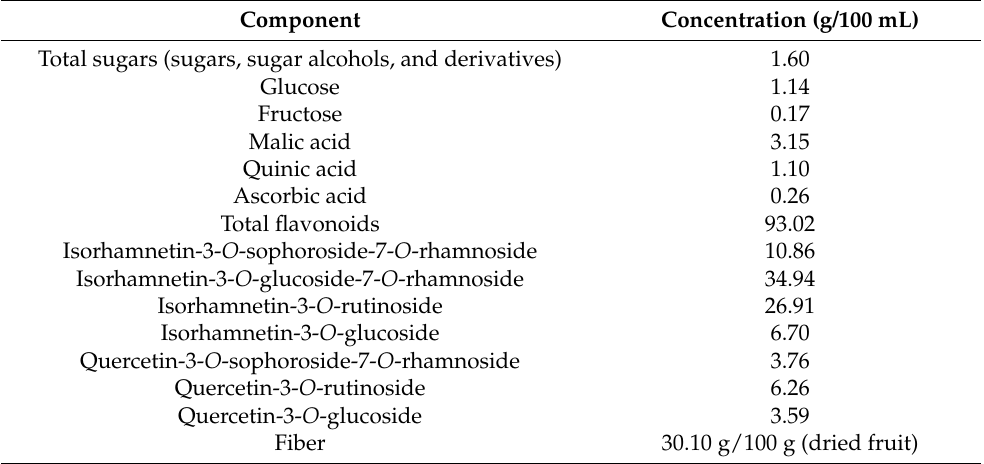
Table 1. Contents of active components in sea buckthorn fruit puree. Component Concentration (g/100 mL) Total sugars (sugars, sugar alcohols, and